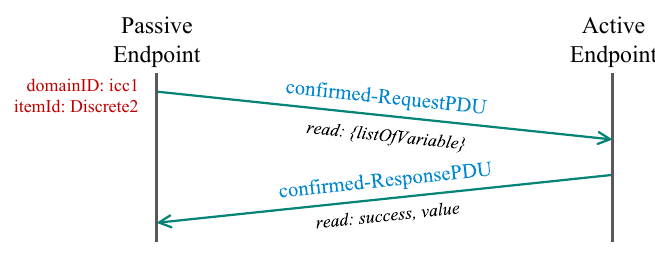
Figure 4. TASE.2 PULL communication